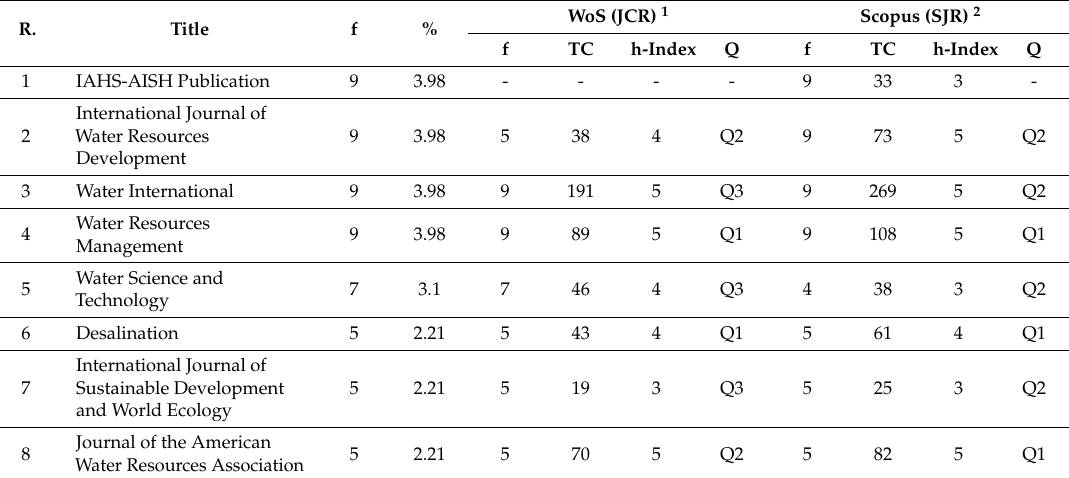
Table 8. Ranking of the most productive journals.